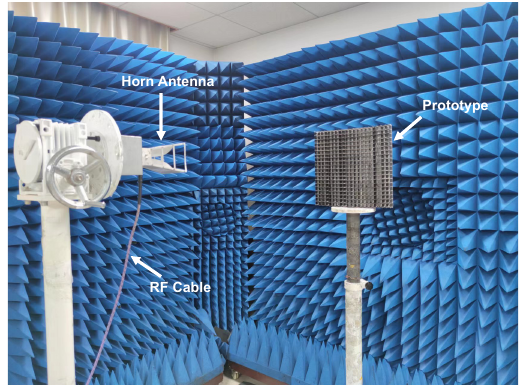
Figure 8. The photograph of the measurement set-up.